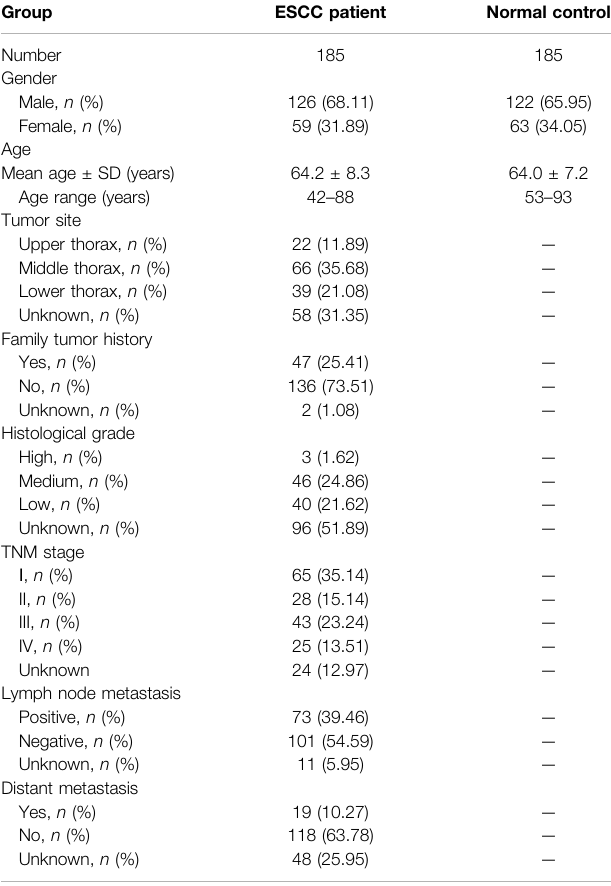
TABLE 1 | Characteristics of study participants. Group ESCC patient Normal